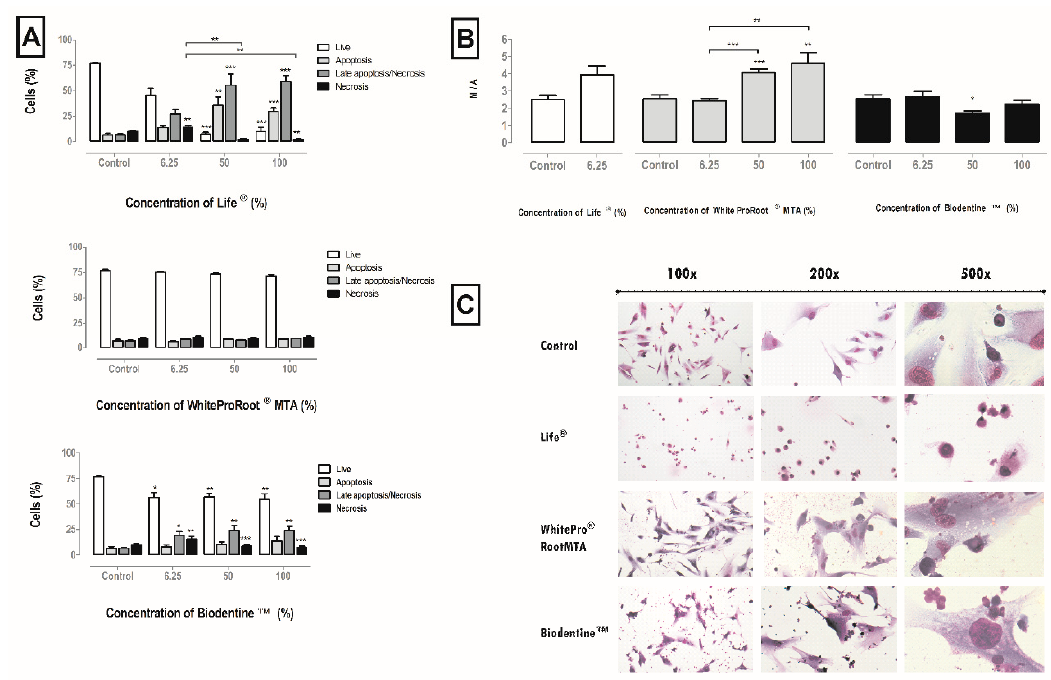
Figure 3. ( A ) Cell viability and types of death in MDPC-23 cells treated with Life ® , WhiteProRoot ® MTA and Biodentine ™ conditioned media after 120 h of exposure. Results represent the percentage of living cells, cell in apoptosis, in late apoptosis or necrosis, and in necrosis. The results represent the mean and standard error of six trials. ( B ) MMP of MDPC-23 cells treated with Life ® , WhiteProRoot ® MTA and Biodentine ™ after 120 h of exposure. The results represent the ratio monomers/aggregates (M/A) for each condition. The results represent the mean and standard error of five trials. In all results, significant differences from control or between conditions are represented by *, where * means p < 0.05, ** means p < 0.01 and *** means p < 0.001. ( C ) MDPC-23 cells stained with May-Grünwald Giemsa after treatment with 50% concentration of biomaterials conditioned medium. The control group represents cells in culture in DMEM with 10% FBS. Images in the left column were obtained with a magnification of 100 × ; the images in the central column were obtained with a magnification of 200 × ; and the images in the column on the right were obtained with a magnification 500 × . These assays were performed in duplicate.